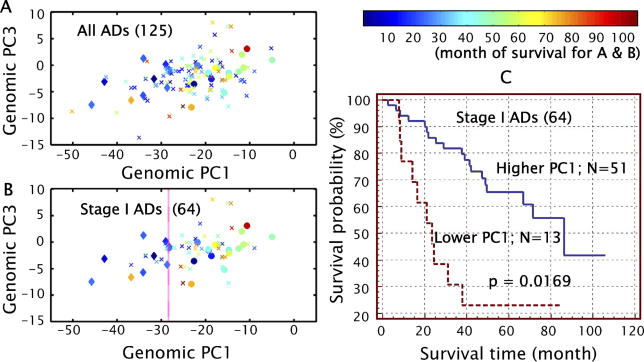
Survival Analyses of Human Lung AD Subclasses from Bhattacharjee et al. [
10] Based on Lung Developmental Association
(A) AD samples identified as forming two distinct subclasses C2 and C4 by Bhattacharjee et al. seen from the genomic PC1 and PC3 perspective of the 472-gene mouse lung development framework. Each sample point is color-coded by its survival time. Circles indicate members of class C4, diamonds indicate members of class C2, and “X”s correspond to all other AD samples.(B) Same as in (A), except that here only the stage I AD samples (such samples within C2, C4, and other) are highlighted. The mouse genomic PC1 halfway separation value between the C2 and C4 samples is noted.(C) K-M plot based on 64 stage I AD patients separated into two groups by the mouse PC1 halfway separation value from (B) (
p = 0.0169); the low-survival group has 13 patients and the high-survival group has 51 patients.